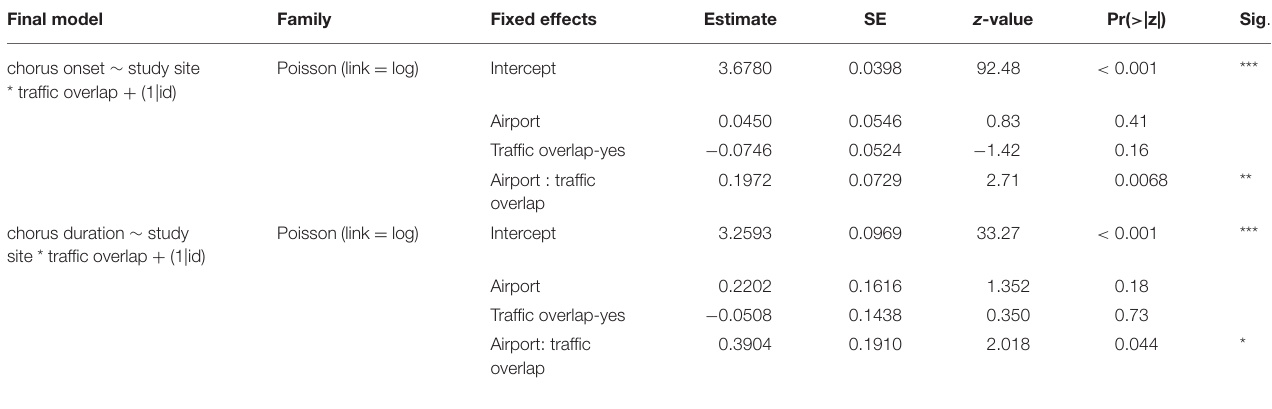
TABLE 3 | Results of blackbird dawn chorus